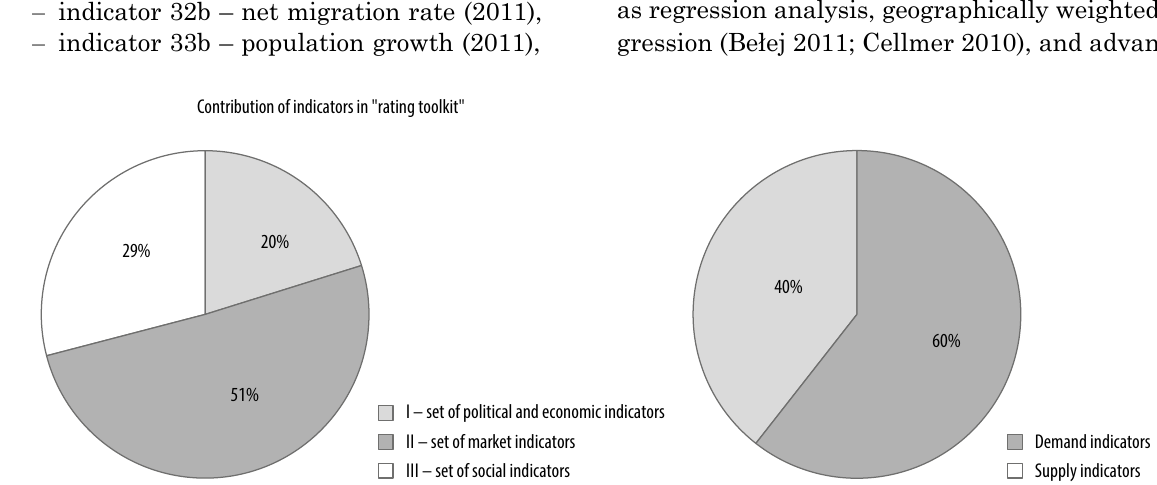
Fig. 3. Share of rating toolkit variables used in analytical models of the real estate market